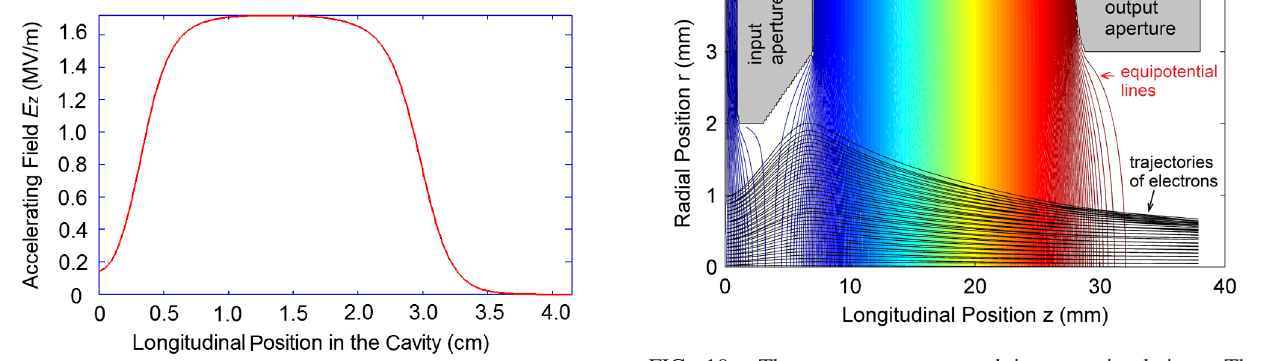
FIG. 9. The longitudinal electric field profile along the accel- erating gap of the gun cavity. The accelerating potential is 36.533